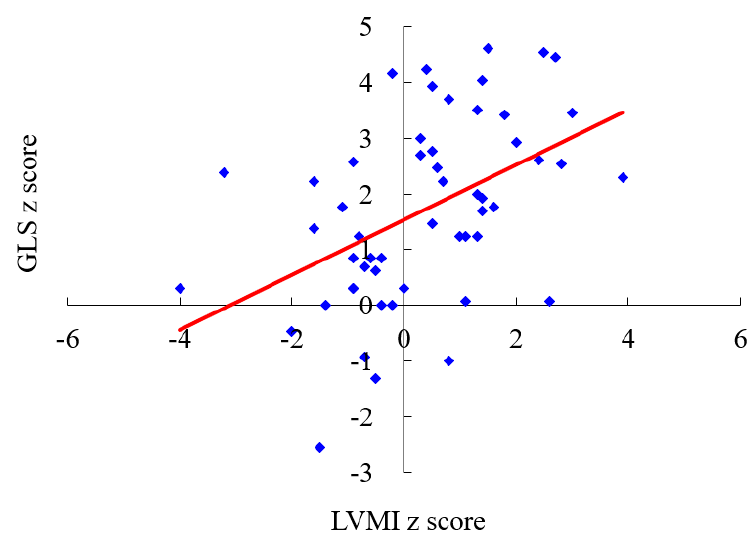
Figure 2. The LVMI z score is positively correlated with the GLS z score ( n = 53, r = 0.469, p < 0.01). LVMI, left ventricular mass index; GLS, global longitudinal strain. The red line represents the trendline. Table 2. The z scores of GLS, LVMI, IVSd, LVPWd, and aortic diameter by MPS type in the 53 patients. Values are displayed as mean (standard deviation).